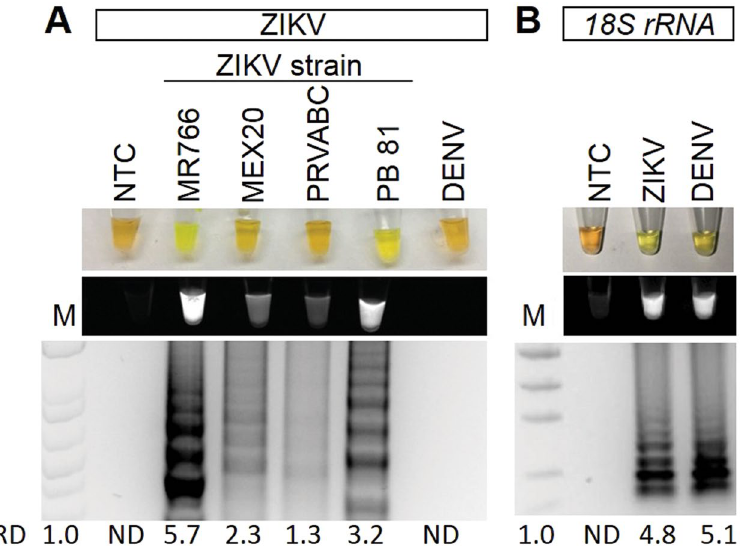
Figure 4. ZIKV and 18S rRNA RT-LAMP in simulated urine samples. Urine samples were spiked with either different strains of ZIKV or DENV and subjected to a ZIKV ( A ) or 18S rRNA ( B ) specific RT-LAMP reaction then visualized by addition of SYBR Green I by eye (upper panel), green fluorescence (middle panel), or gel electrophoresis (bottom panel). Lane M: Low DNA Mass Marker (ThermoFisher Scientific); NTC: No template control (negative control). Relative density (RD) of the entire bands for a column relative to the DNA Mass Marker are indicated below the corresponding lane. Lanes that did not have any detectable bands over background are reported as not detectable